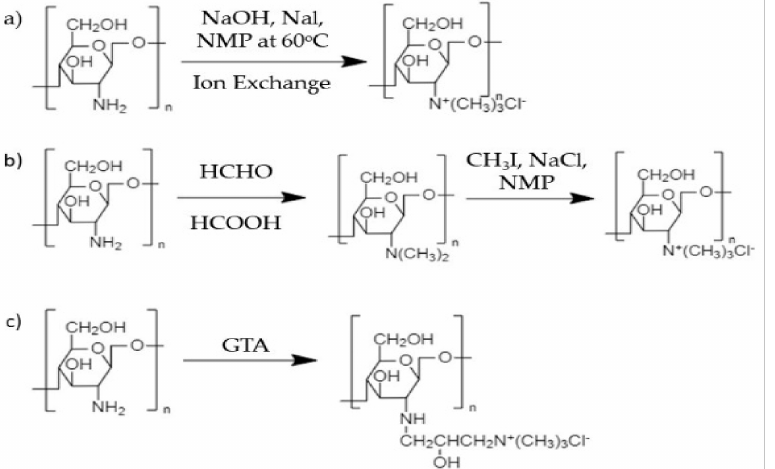
Figure 3. Several synthesis reactions for quaternized chitosan derivatives: ( a ) Direct quatenization of chitosan producing TMC, ( b ) N-alkylation of TMC, and ( c ) epoxy-derivative ring-opening producing N -((2-hydroxy-3-trimethylammonium)propyl) chitosan chloride (HTCC).